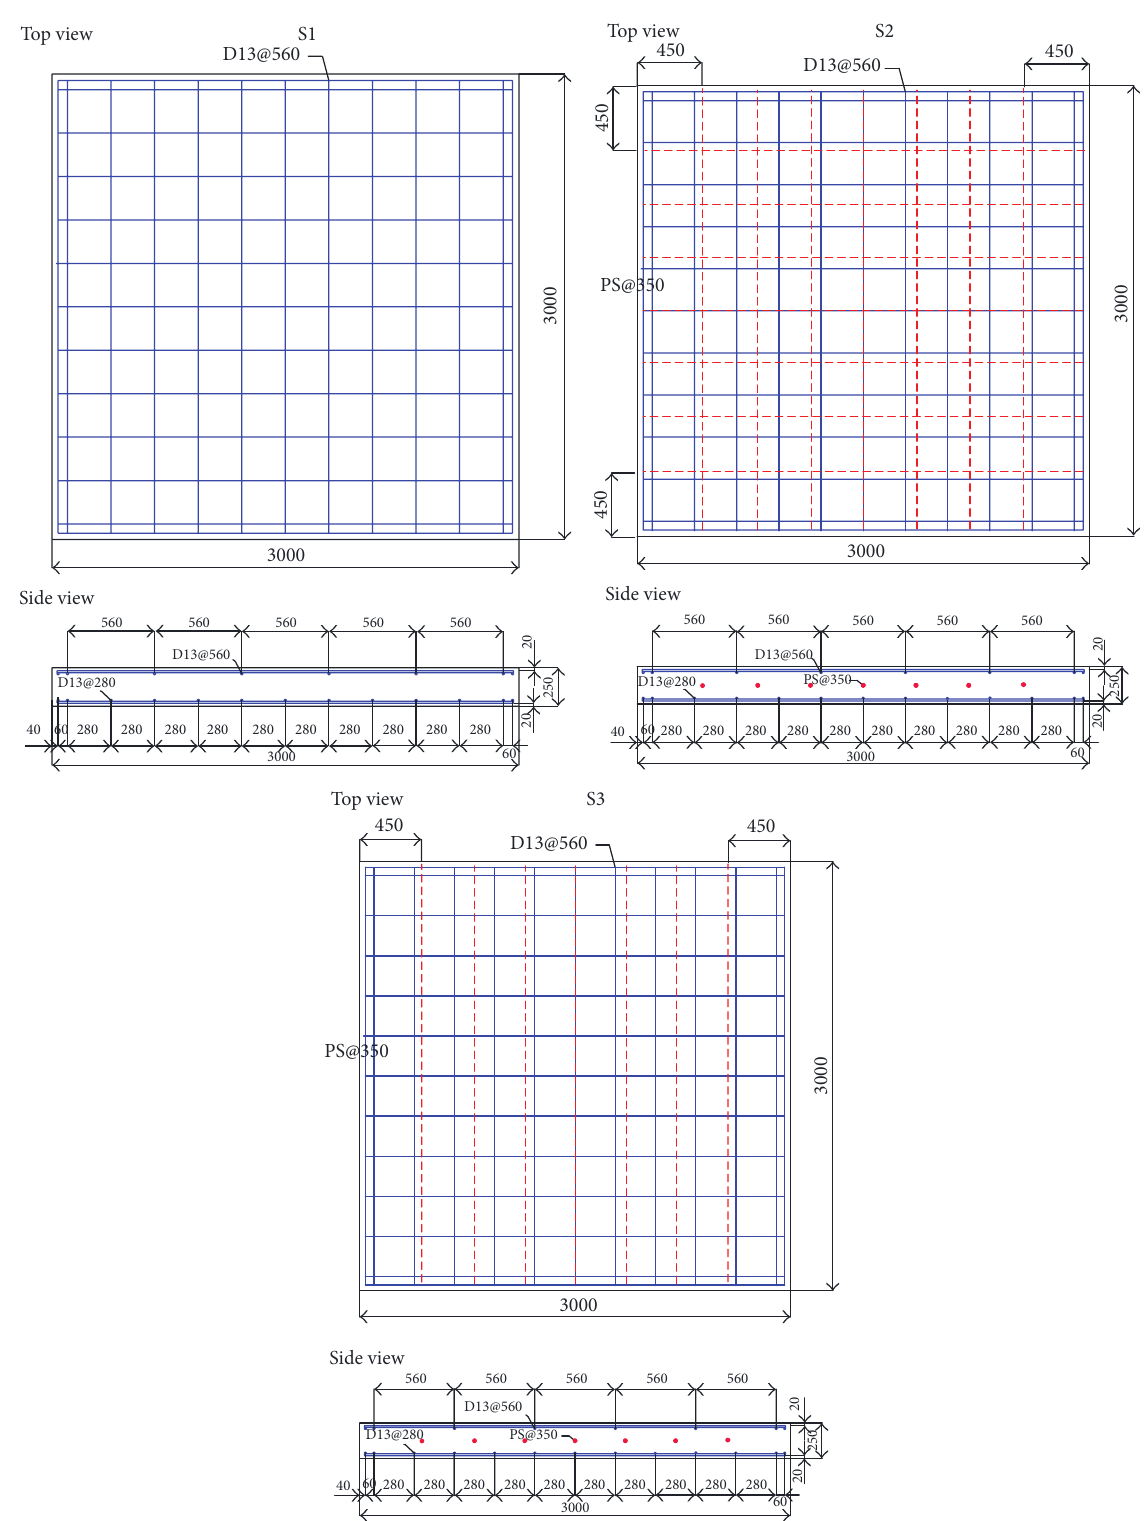
Figure 7: The plan and side views of specimens S1, S2, and S3. All dimensions in